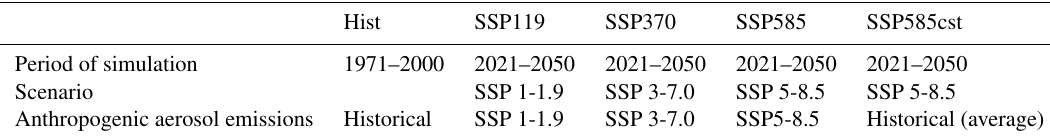
Table 1. Summary of the main characteristics of the five simulations used in this